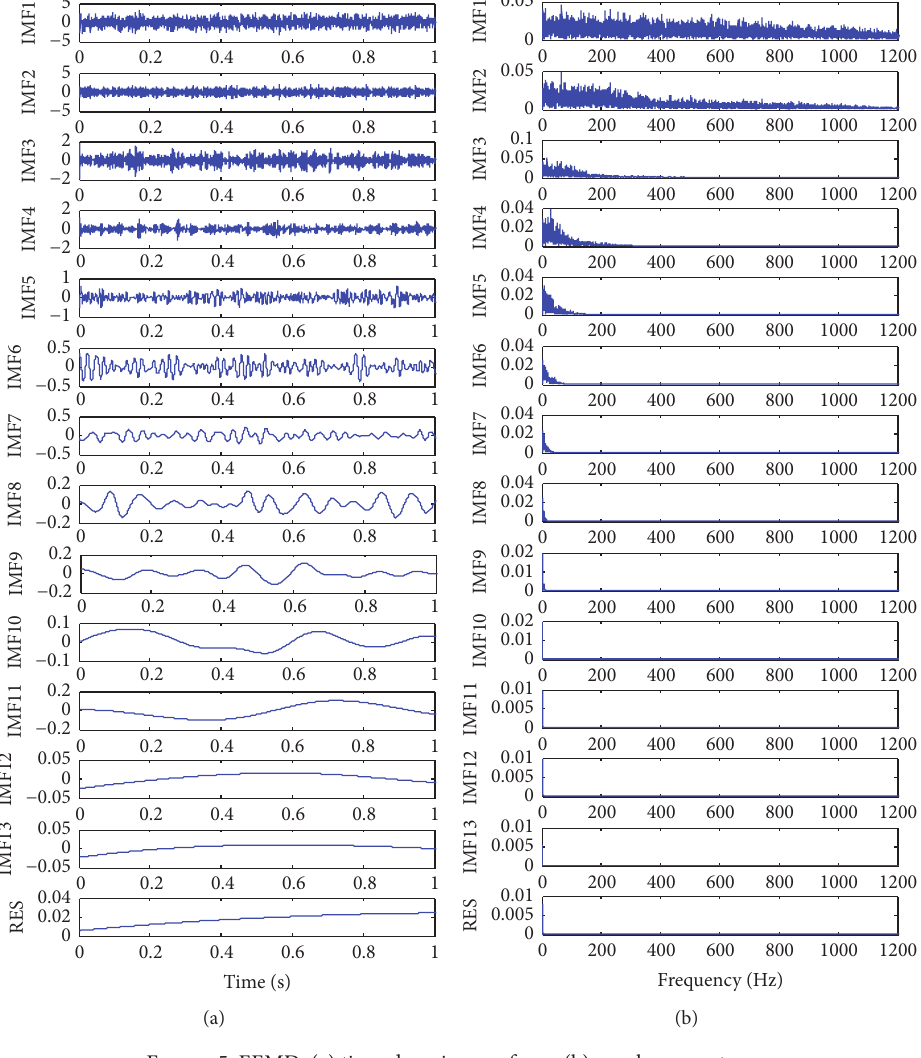
Figure 5: EEMD: (a) time-domain waveform; (b) envelope spectrum. Table 2: The optimal parameter combination of adaptive stochastic resonance of IMF1 ∼